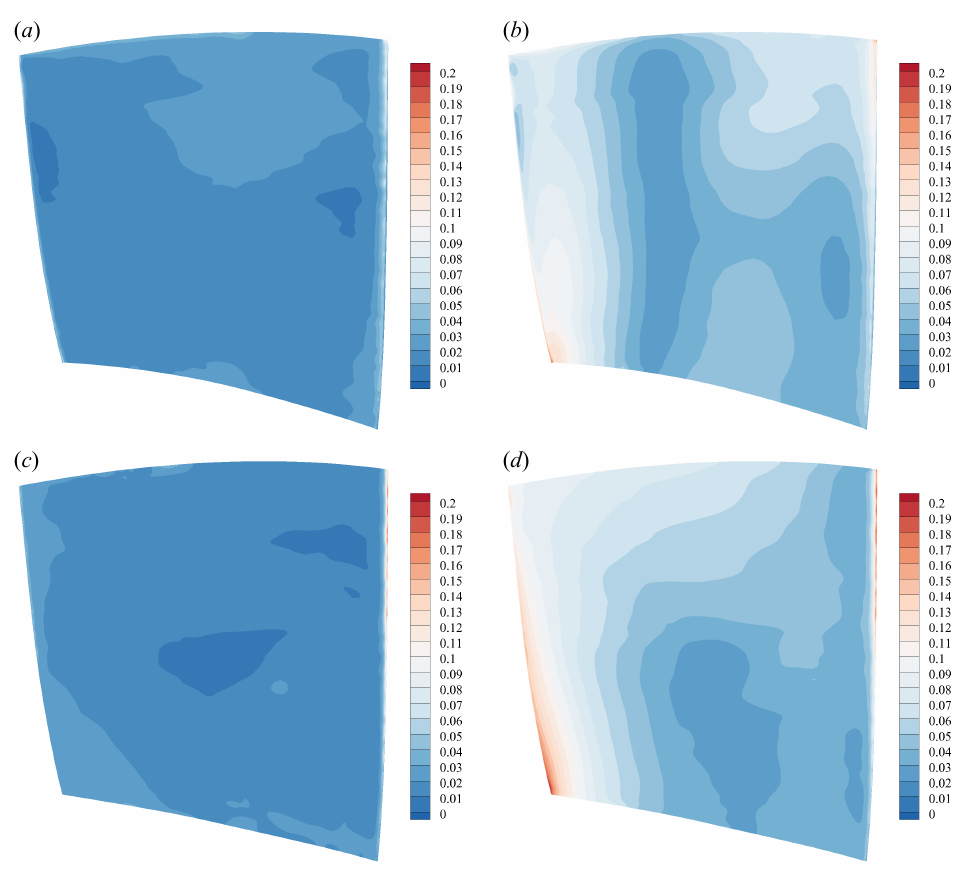
Figure 22. Distributions of the pressure fluctuation amplitude on the rotor blade. ( a ) g = d 0 , pressure surface, ( b ) g = d 0 , suction surface, ( c ) g = 0.1 d 0 , pressure surface, ( d ) g = 0.1 d 0 , suction